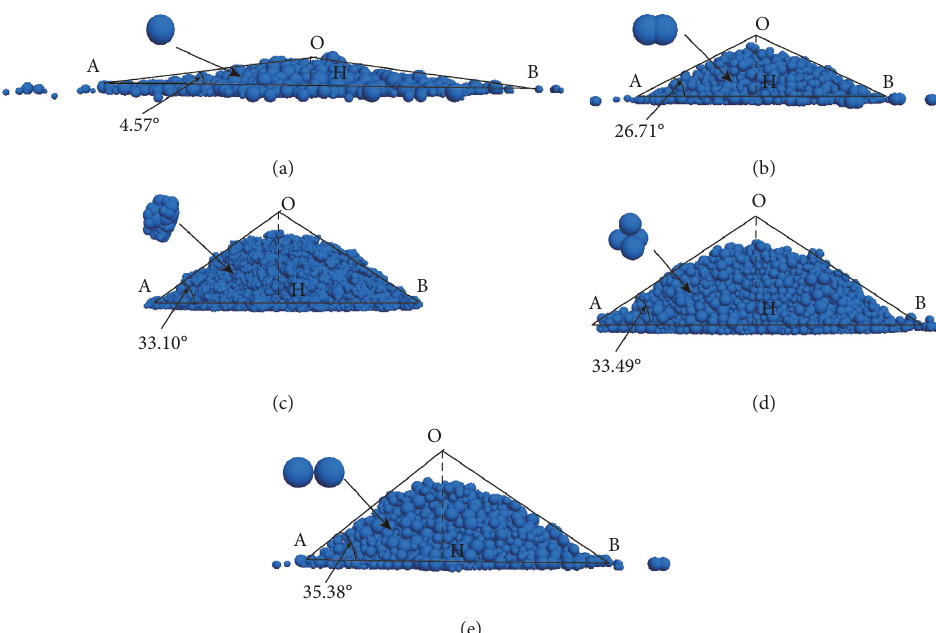
Figure 12: The final states of the granular piles for five models. (a) 1-ball model; (b) 2-ball with overlap model; (c) real ballast model; (d) 4-ball model; (e) 2-ball without overlap model.